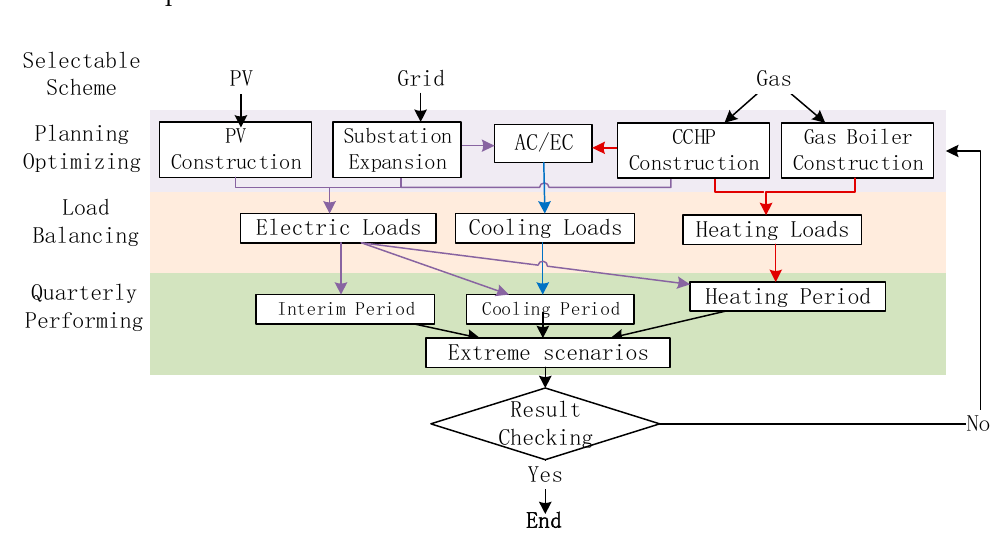
Figure 3. Optimization strategy of IEMG planning.